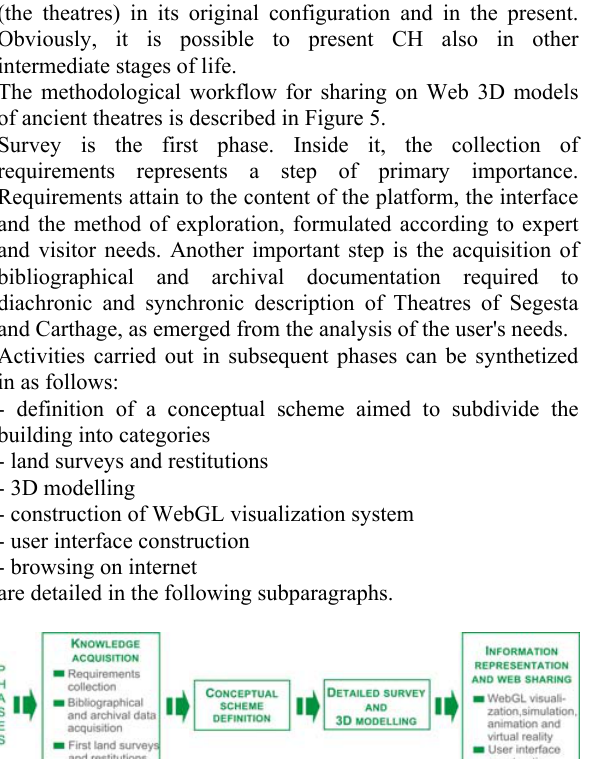
Figure 2. Localization of theatres of Segesta and Carthage (Tunisia)